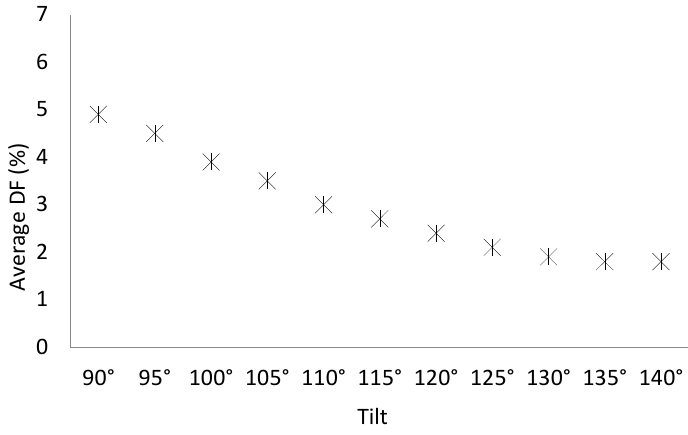
Figure 10. Average daylight factor in the whole unit with different façade